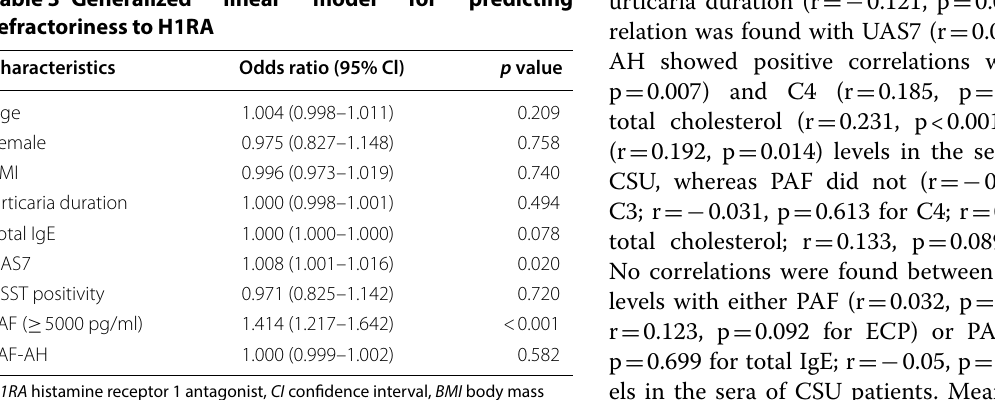
Table 3 Generalized linear model for